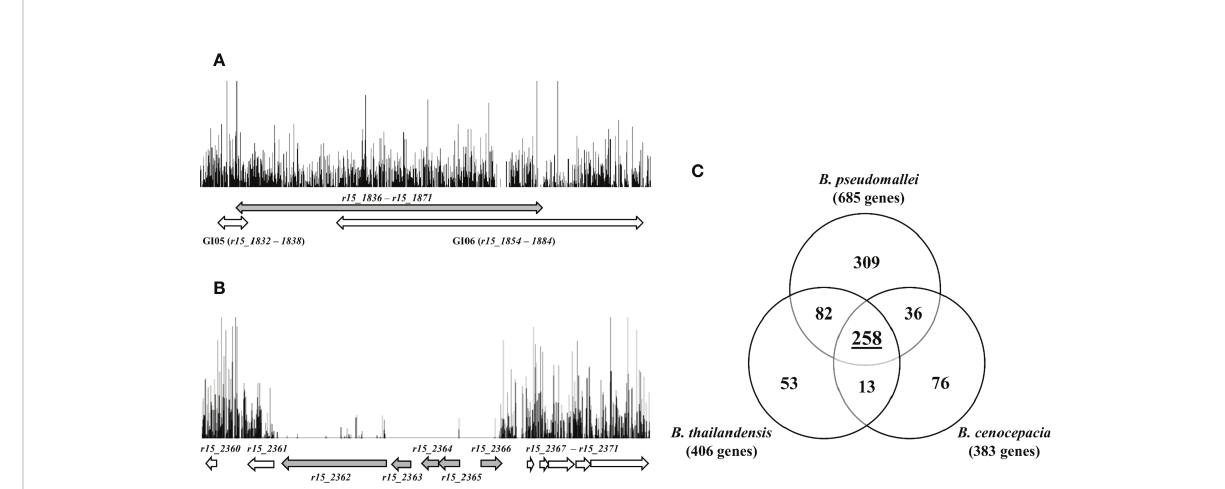
FIGURE 3 (A) Frequency and distribution of transposon insertions in GI05 and GI06 of B. pseudomallei R15. Each vertical line represents the position of unique TIS with the height corresponding to the sequencing depth. Grey double-headed arrow indicates homologous region of K96243 genomic island 8 (GI8). White double-headed arrows indicate location of R15 genomic islands (GI05 and GI06). (B) Insertions pro fi le of B. pseudomallei R15 genomic region r15_2360 − r15_2371 . Grey arrows indicate essential genes and white arrows indicate non-essential genes. (C) Venn diagram shows the overlap numbers of essential genes in three Burkholderia species: B. pseudomallei , B. cenocepacia and B. thailandensis . A total of 258 common Burkholderia core essential genes were derived experimentally using TraDIS and